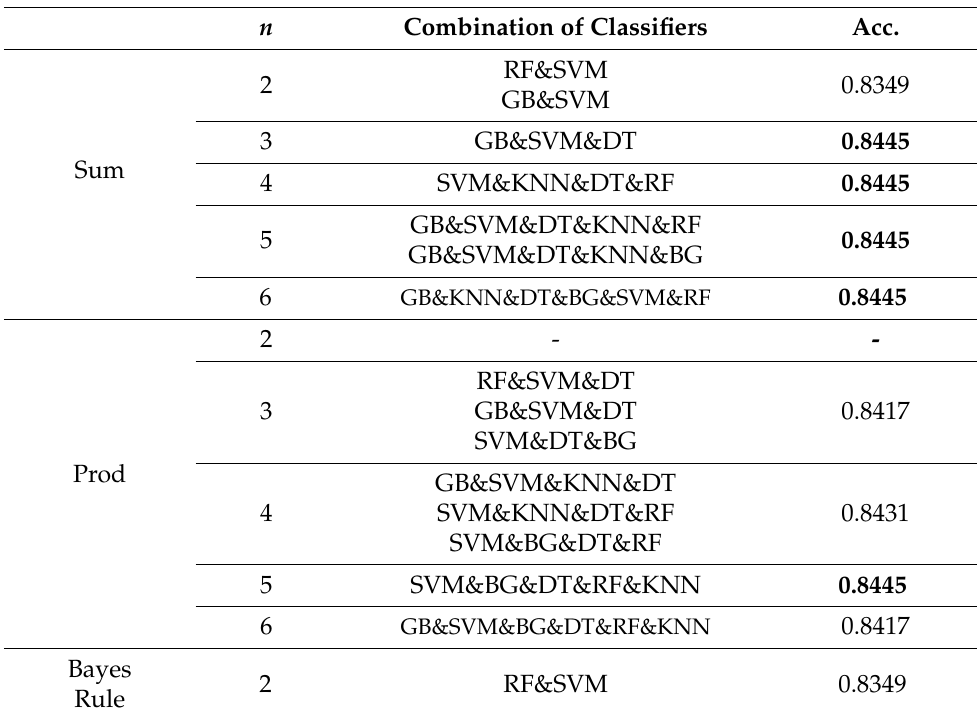
Table 3. The results of the combination of the classifiers in age recognition using different fusion strategies. n is the number of classifiers involved in the fusion process. The numbers in bold are the best